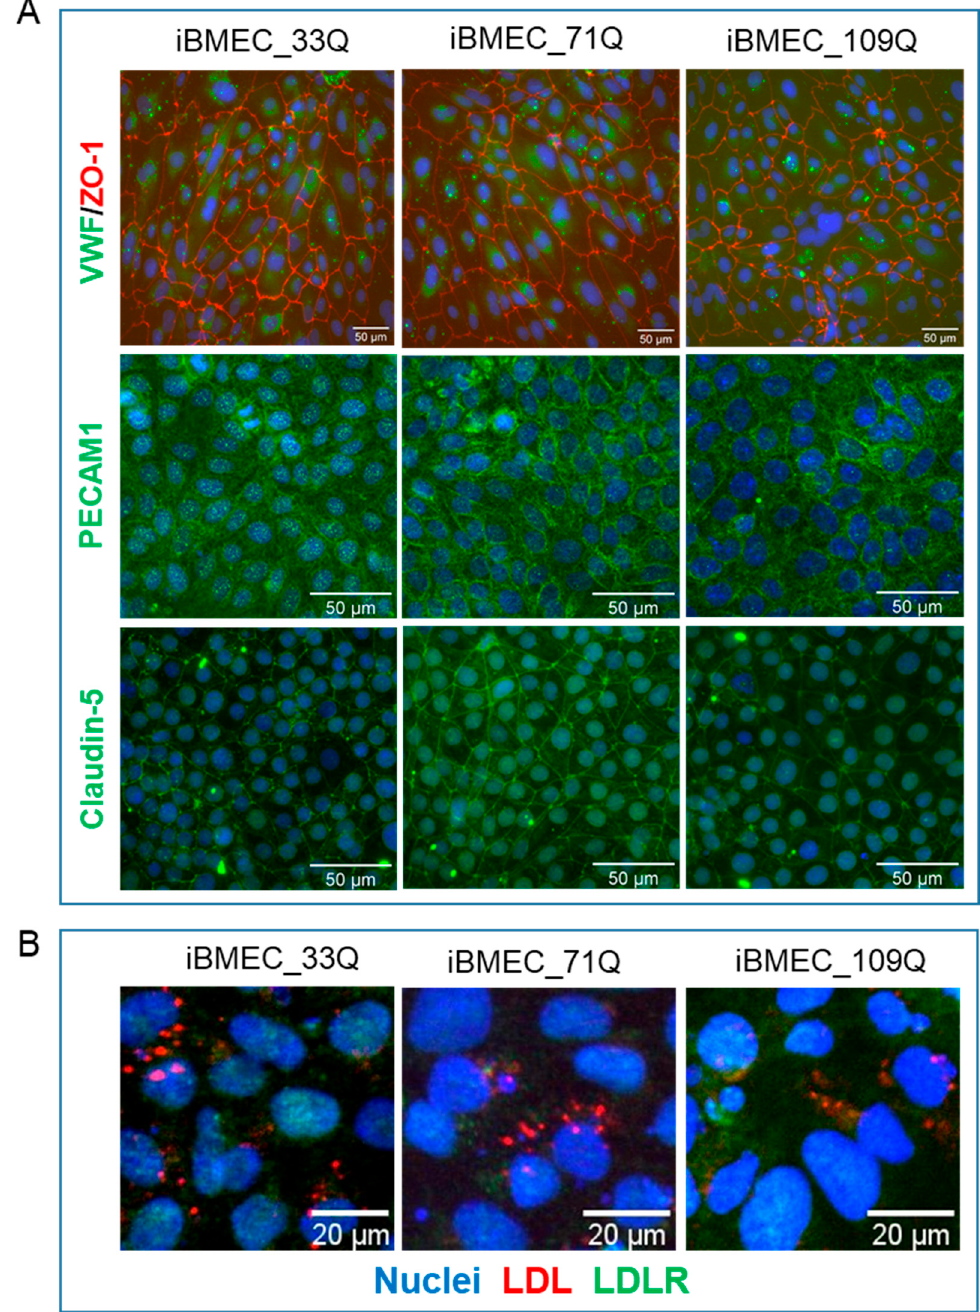
Figure 2. iPSC differentiation into iBMECs. ( A ). Representative immunofluorescence staining, at d1 co-culture in transwell filters, demonstrating the expression of endothelial relevant proteins: vWF, ZO- 1, PECAM1, and Claudin-5. Nuclei were counterstained with Hoechst (blue). Scale bar represented 50 µm. ( B ) LDL uptake (in red) by iBMECs (at D10). In green, the intracellular distribution of LDLR was also reported (scale bar indicates 20 µm).